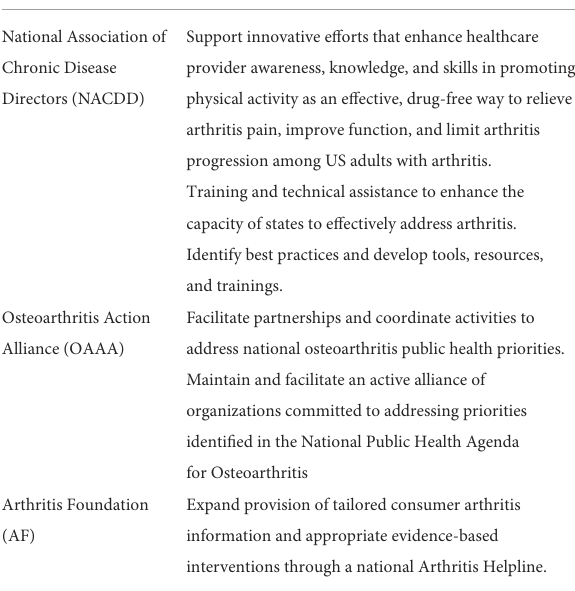
TABLE 1 Stakeholders funded through CDC initiative to advance arthritis public health priorities.